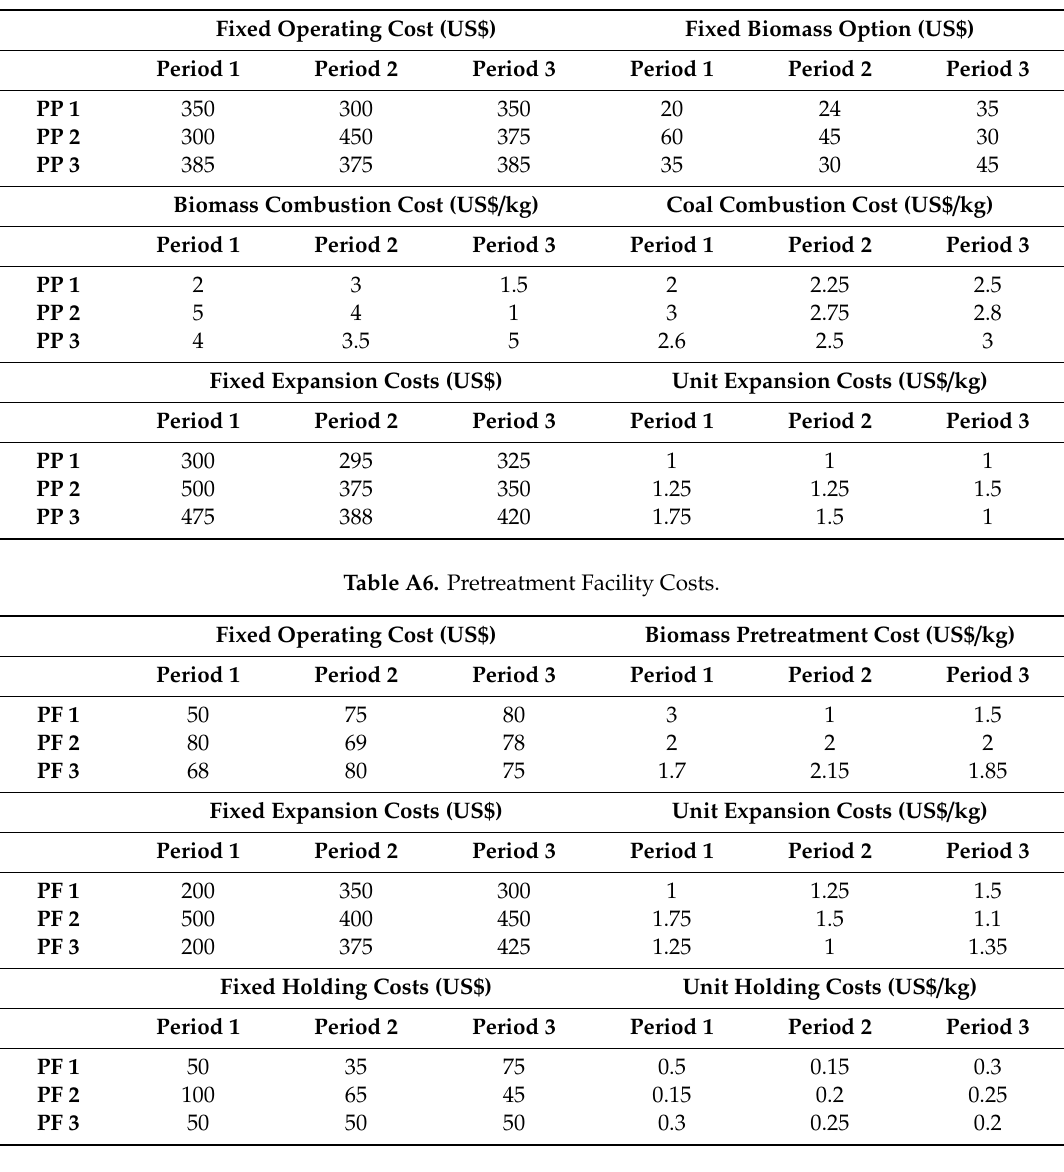
Table A7. Emissions